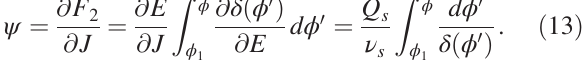
FIG. 3. (a) rf potential V ð ϕ Þ as a function of longitudinal phase ϕ for r ¼ 1 = 2 , h ¼ 2 , and Δ ϕ ¼ 30 °. The particle energy levels o E 1 ¼ − 0 . 1 , E 2 ¼ 0 . 0 , E 3 ¼ 0 . 1 , E 4 ¼ 0 . 2 , and E 5 ¼ 0 . 3 are shown corresponding to (b) each respective torus of motion in phase